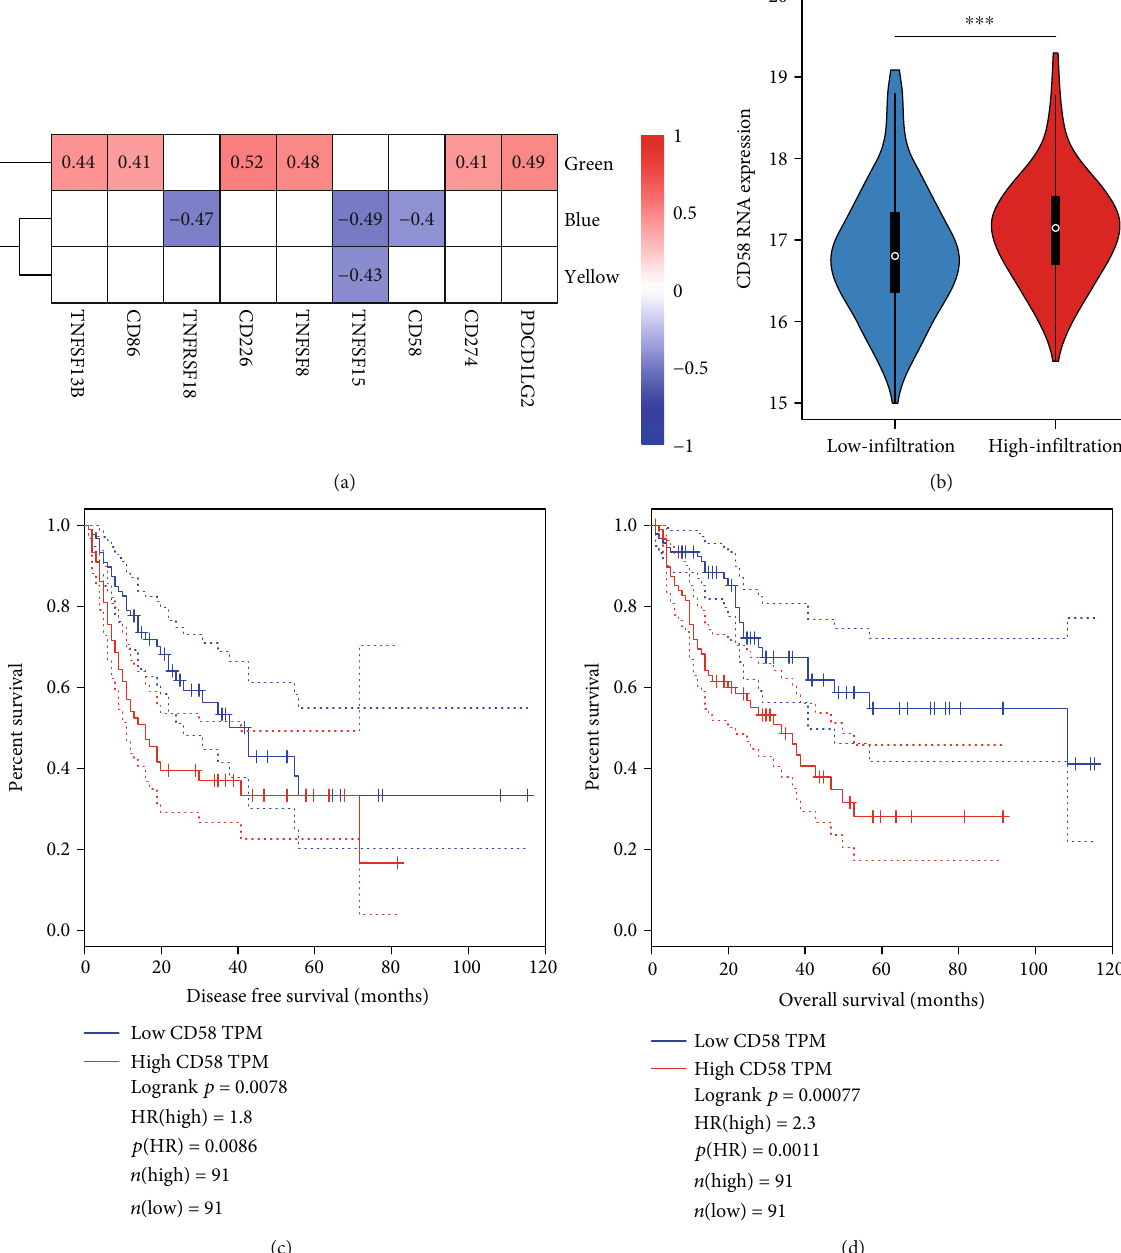
Figure 7: The association between functional modules and the immunomodulatory regulators in HCC. (a) The relative expression abundances of the functional modules estimated by ssGSEA. (b) The CD58 RNA expression level in tumor tissues. CD58 was highly expressed in HCC tissues with high in fi ltrating levels of immune cells ( P value < 0.001) (c) The disease-free survival and (d) the overall survival for patients with low (below median CD58 expression value, n = 91 ) or high (above median CD58 expression value, n = 91 ) expression level. Kaplan-Meier survival curves were generated based on TCGA data using the GEPIA2